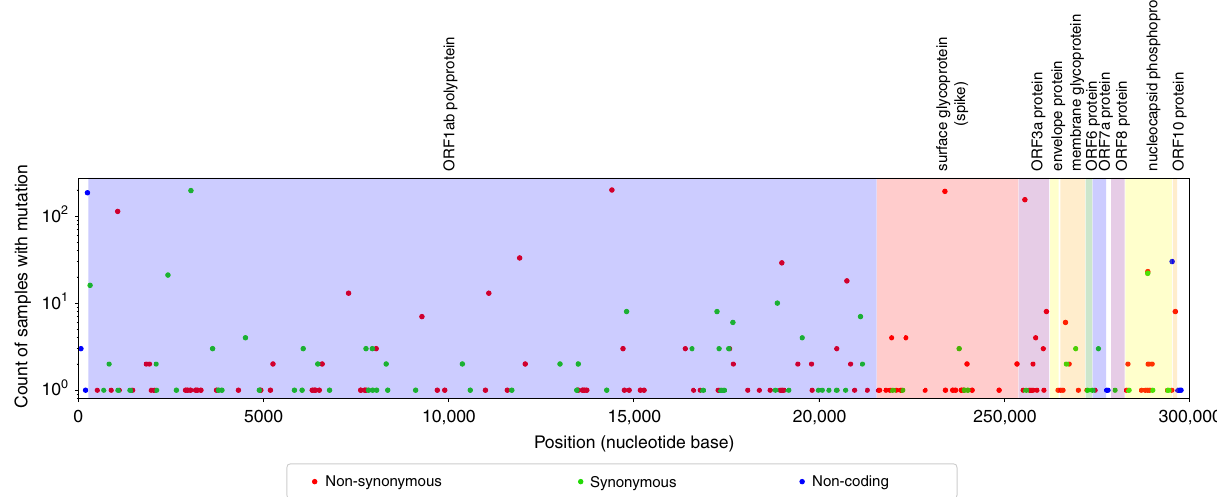
Fig. 1 Variation found in sequenced samples from Israel. The x -axis corresponds to the SARS-CoV-2 genome and the y -axis provides counts of identi fi ed SNVs across the viral genome. Source data are provided as a Source Data fi